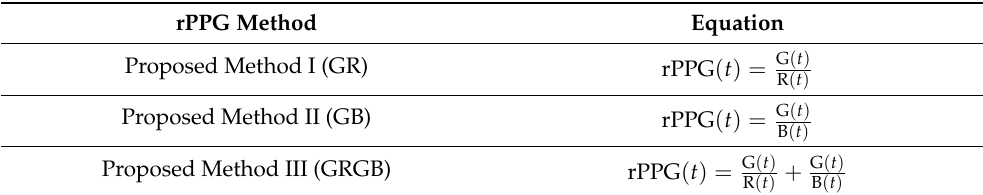
Table 1. Summary of the introduced rPPG methods. Note: B = blue channels, G = green channel, R = red